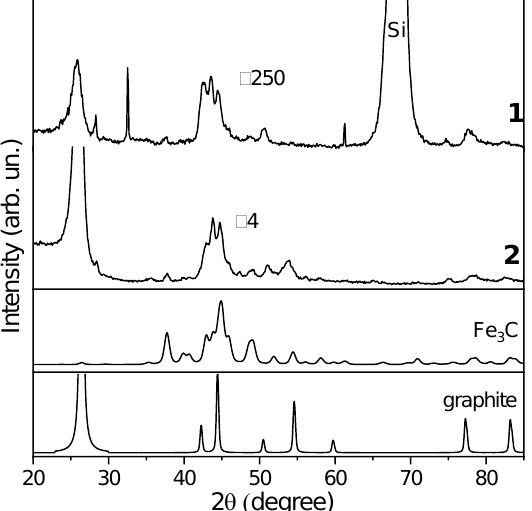
Figure 3. XRD patterns of MWCNT array on silicon substrate (1) and MWCNT sample detached from substrate (2) in comparison with reference patterns of iron carbide Fe 3 C and graphite. The patterns (1) and (2) are presented with zoom of 250 and 4, respectively.